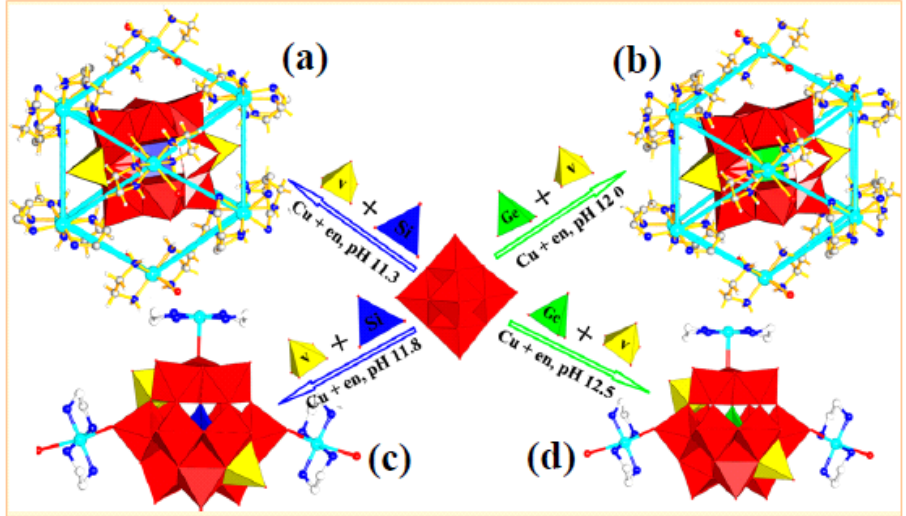
Fig. 14. Compounds a and b are both composed of the bicapped heteropolyoxonibate core surrounded by a shell. Compounds c and d are also composed of a bicapped polyoxoanion. Adapted from Ref [70].